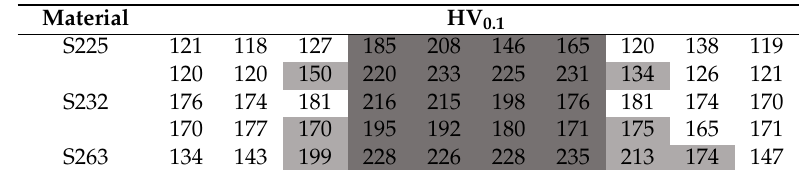
Table 7. Microhardness measurements for S 225, S232 and S263. White background: base material, middle grey: heat-affected zone, dark: weld seam.